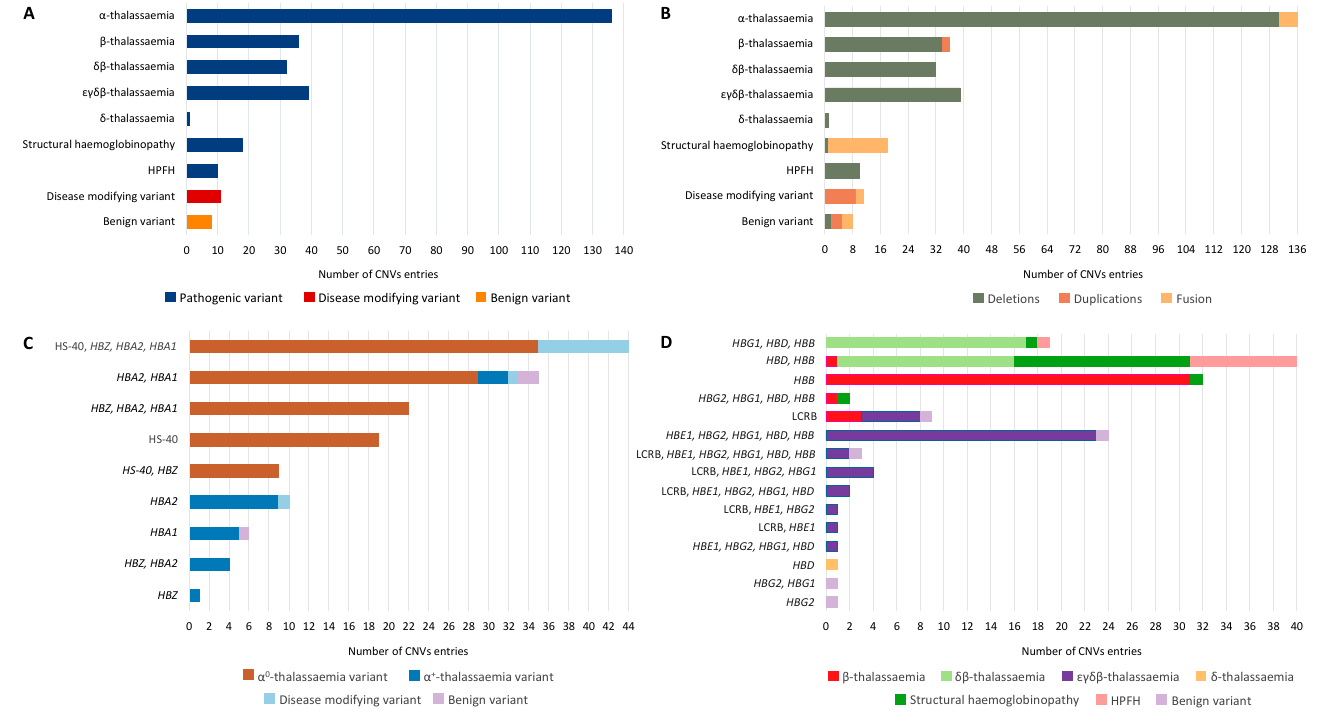
Figure 2. Descriptive analysis of the CNV dataset. ( A ) Haemoglobinopathy groups/phenotypes and variant functionality, ( B ) Haemoglobinopathy groups/phenotypes and variant type, ( C ) Affected genes associated with α -globin locus variants, ( D ) Affected genes associated with β -globin locus variants.